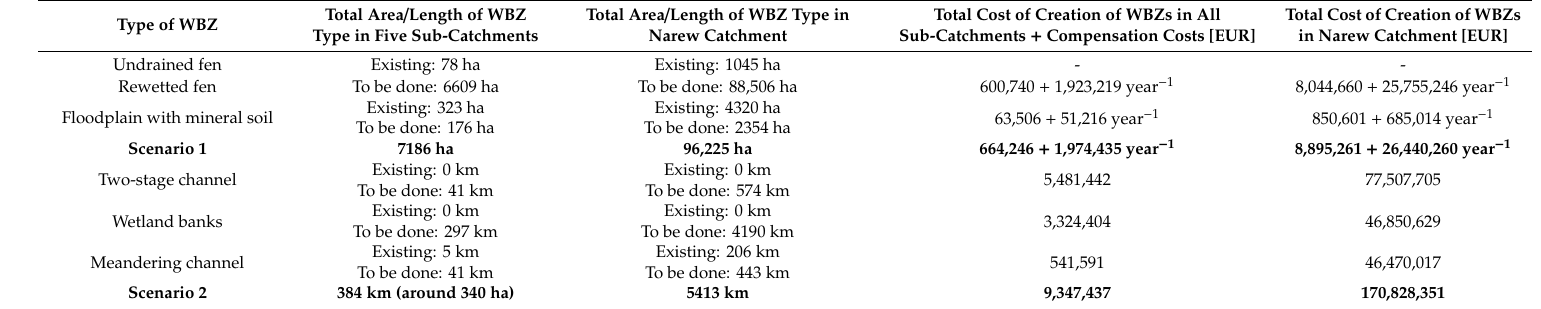
Table 5. Cost of implementation WBZs in scenario 1 (polygonal WBZs) and in scenario 2 (linear WBZ) in five sub-catchments and upscaled for the whole analysed part of Narew